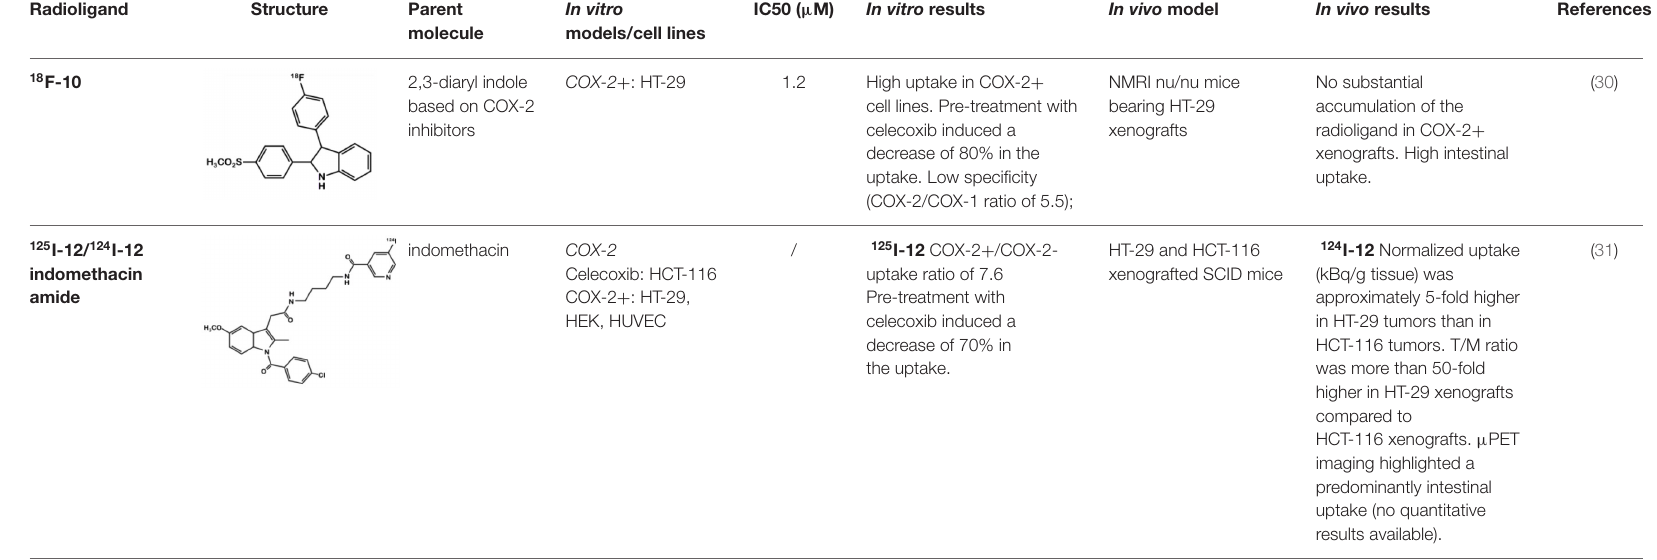
The table summarizes for each probe: chemical structure, parent molecule, IC 50 , cell lines used for in vitro studies and conclusion of these studies, models used for preclinical studies and conclusions, reference article. Cell lines with high COX-2 expression: HT-29, Human colorectal adenocarcinoma cells; HCA-7, Human colon adenocarcinoma cells; HUVEC, human umbilical vein endothelial cell; HEK, human embryonic kidney. Cell lines with low COX-2